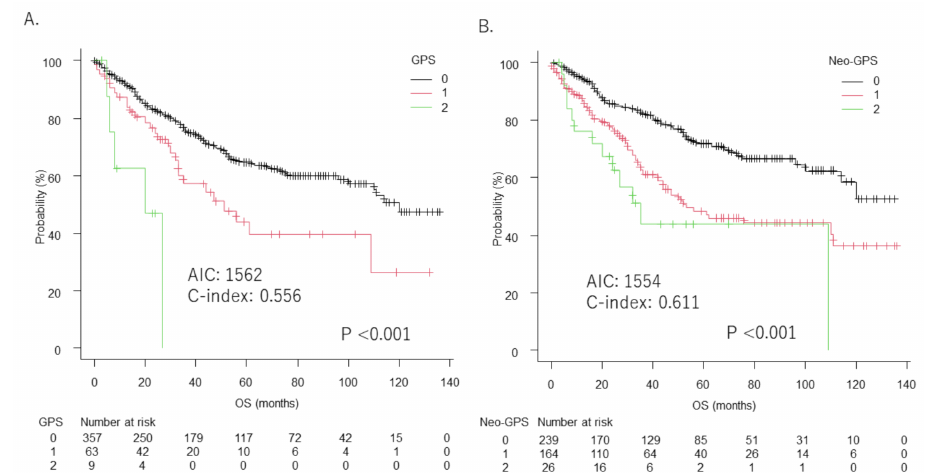
Figure 1. Comparison between GPS and neo-GPS for prediction of overall survival (OS). ( A ) Median